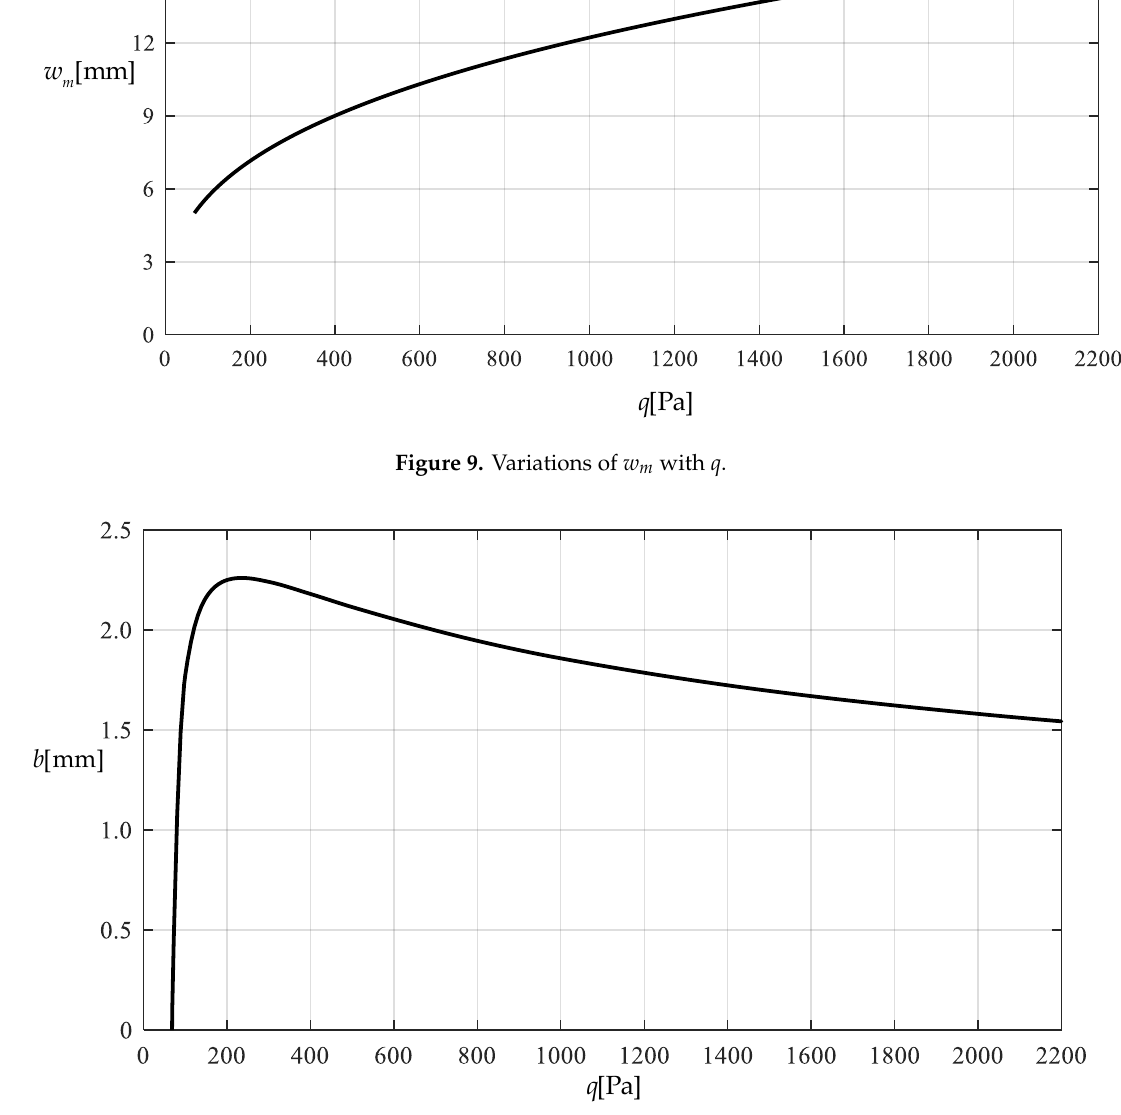
Figure 10. Variation of b with q .